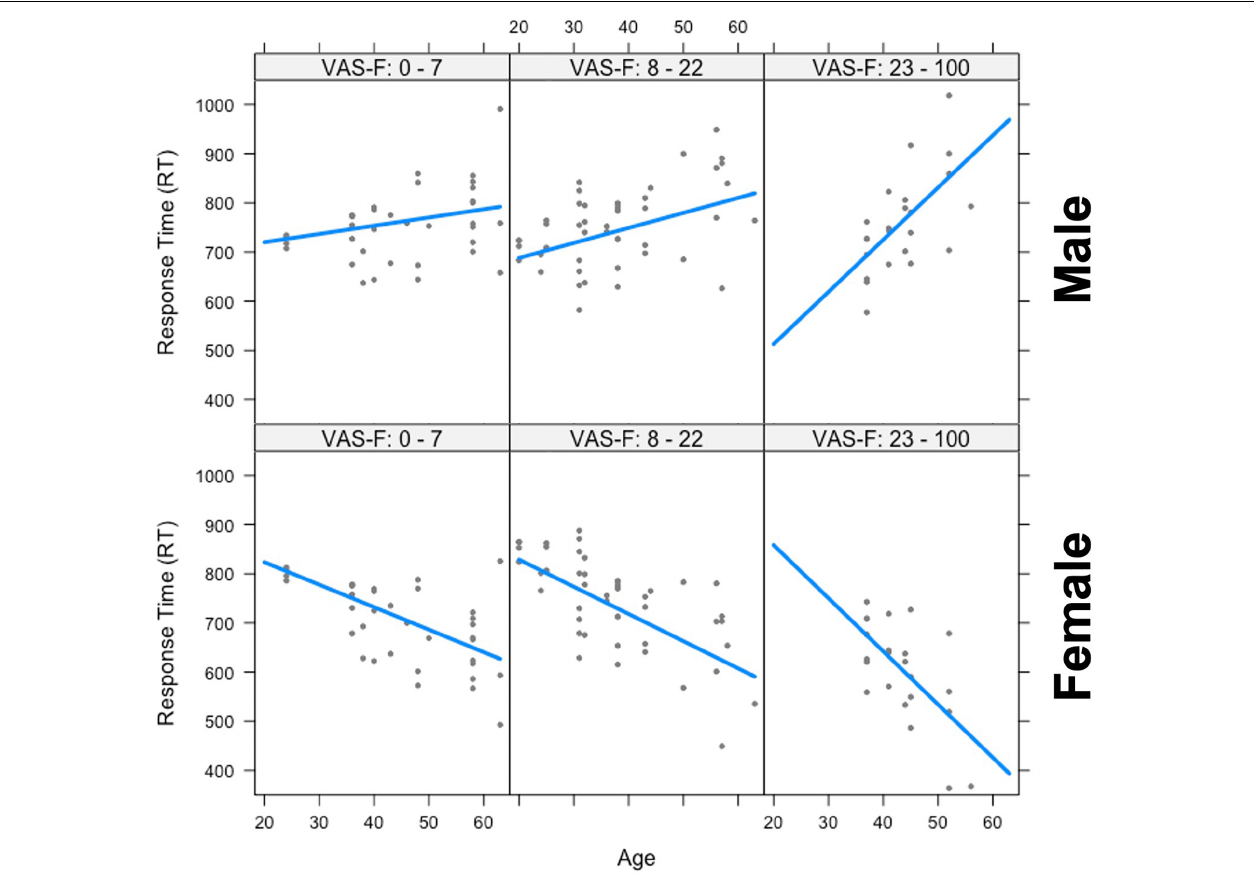
FIGURE 2 | The interaction between age, gender, and visual analog scale of fatigue (VAS-F) on Response Time (RT). Age is plotted in years and RT is plotted in milliseconds. The top three panels show the positive relationship between RT and age for men and the bottom three panels show the negative relationship between RT and age for women across increasing values of VAS-F, indicated at the top of each panel. For the plot, the VAS-F data was divided into three bins for expository purposes only. In the analysis, the VAS-F data was continuous. The lines represents the best fitting linear relationship between RT and